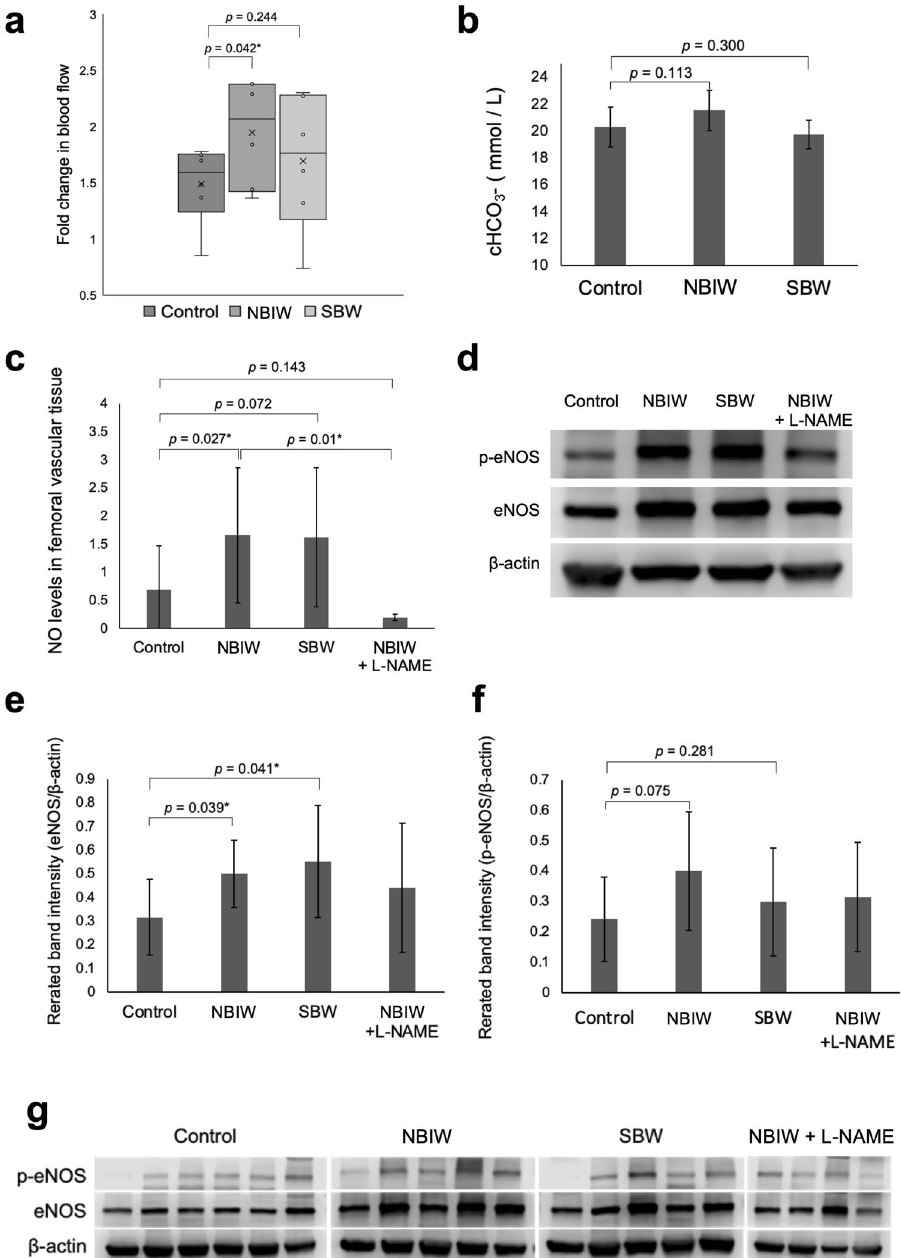
Figure 1. Effects of neutral bicarbonate ion water in vivo. ( a ) Fold change in blood flow in BALB/c mice after bathing. Flow was higher in the neutral bicarbonate ionized water (NBIW) group than in the control group ( p = 0.042*). (Control: ultrapure water bathing, n = 6; NBIW, n = 6; SBW: sodium bicarbonate water bathing, n = 6). ( b ) Blood bicarbonate ion level after bathing. NBIW: p = 0.113 vs control, Hedge’s g = 0.83 (95% CI, − 0.46 to 2.124); SBW: p = 0.300 vs control, Hedge’s g = − 0.44 (95% CI, − 1.892 to 1.003). (Control: n = 5, NBIW: n = 5, SBW: n = 3). ( c ) Level of nitric oxide (NO) in femoral vessel tissue after bathing. The increase was significantly higher in the NBIW than in the control group † ( p = 0.027*). L-NAME (100 mg/kg) significantly suppressed the NBIW-associated NO increase ( p = 0.01*). ( d ) Representative Western blot analysis of endothelial nitric oxide synthase (eNOS) and phospho-eNOS (p-eNOS) in a blood vessel in each group (protein carried per lane: 20 μg) in samples from all animals. The β-actin blot is from a different part of the gel blotted with eNOS. Blot images of all animals † are shown in the Supplementary Information. ( e ) The eNOS level in the femoral vessel tissue was significantly higher in the NBIW and SBW groups than in the control group † (NBIW: p = 0.039*, SBW: p = 0.041*). ( f ) The p-eNOS level tended to be higher in the NBIW and SBW groups than in the control group (NBIW, p = 0.075; d = 0.95; 95% CI, − 0.299 to 2.205; SBW, p = 0.281; d = 0.36; 95% CI, − 0.833 to 1.56) and was numerically higher in the NBIW group than in the SBW group. ( g ) Western blot images of all tested animals. † ( c – g ) Control: n = 6, NBIW: n = 5, SBW: n = 5, NBIW + L-NAME: n = 4. For ( a , b , e , f ) Student’s t test was used, and for c, Mann–Whitney U Test (* p <